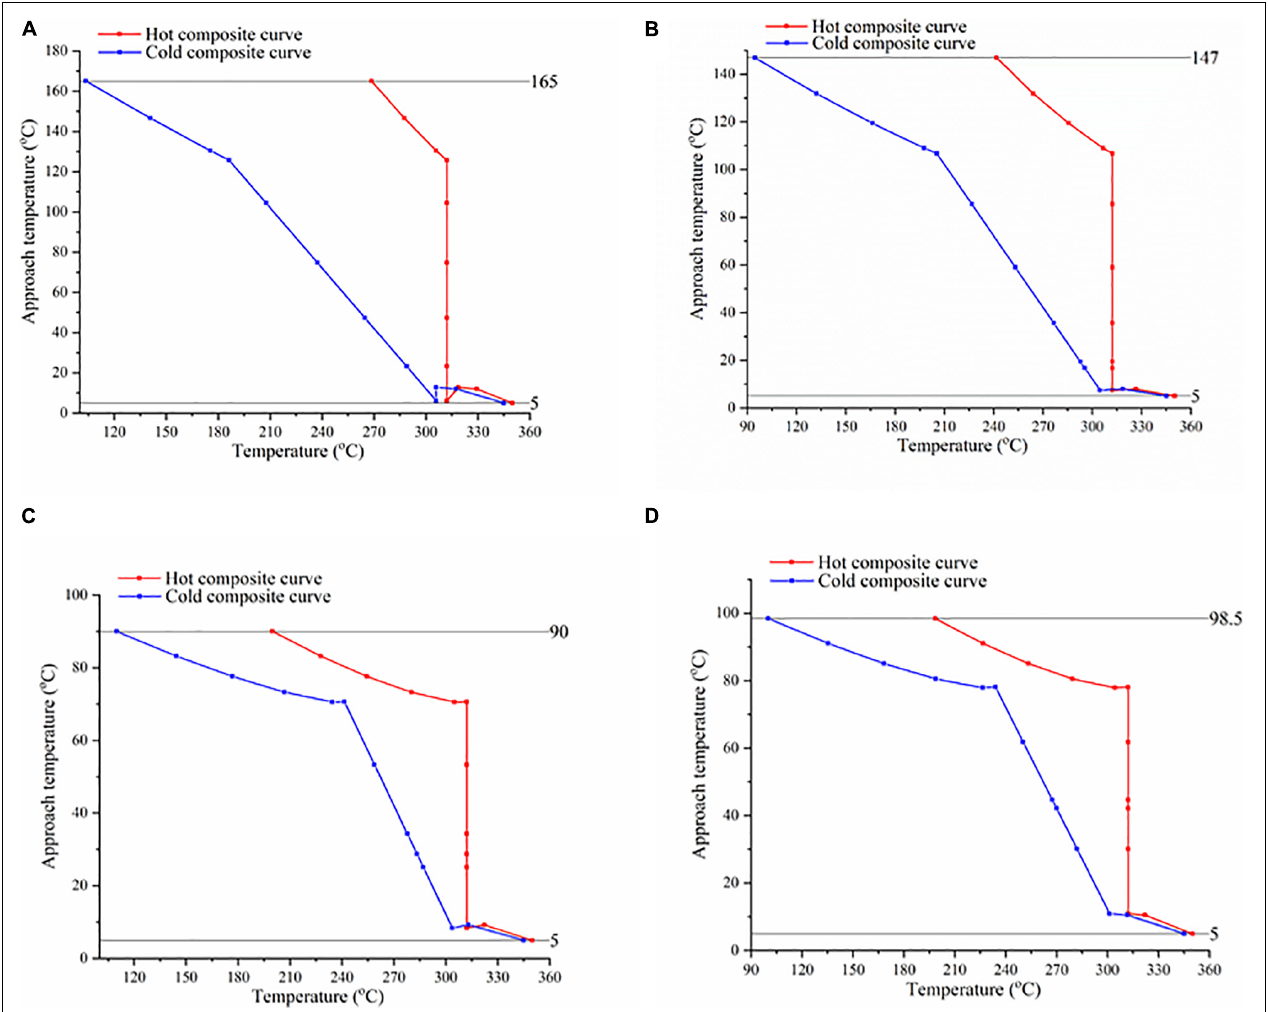
FIGURE 3 | Temperature difference composite curves of organic Rankin cycle (ORC) systems using (A) toluene, (B) methylcyclohexane, (C) n -butanol, and (D) i -butanol as the working